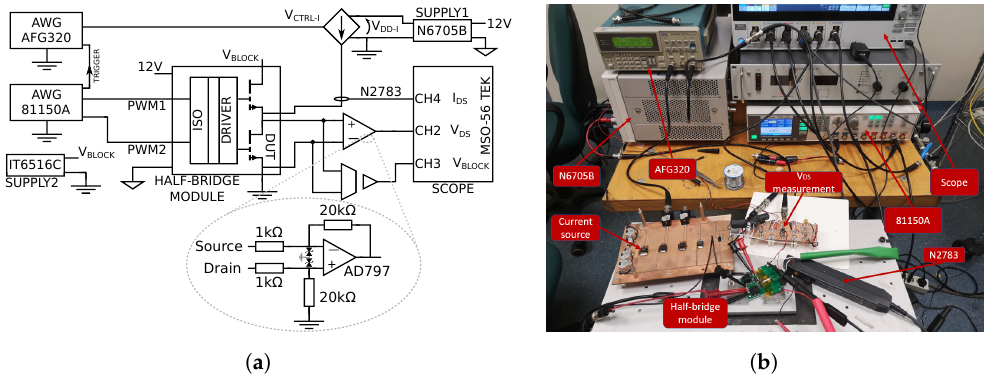
Figure 6. Characterization set-up description. ( a ) Characterization set-up schematic; ( b ) photograph of the characterization set-up (IT6516C and isolated probe are not